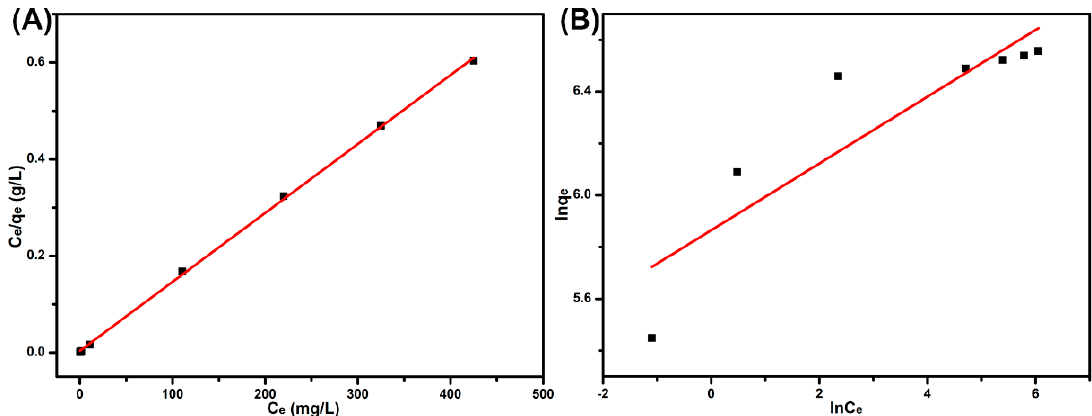
Figure 8. Langmuir isotherm ( A ) and Freundlich isotherm ( B ) for the adsorption of MB onto SPEN-Al-2. Table 2. Adsorption isotherm constants for the adsorption of MB onto SPEN-Al-2. Isotherms Parameters (Temperature = 298.15 K)